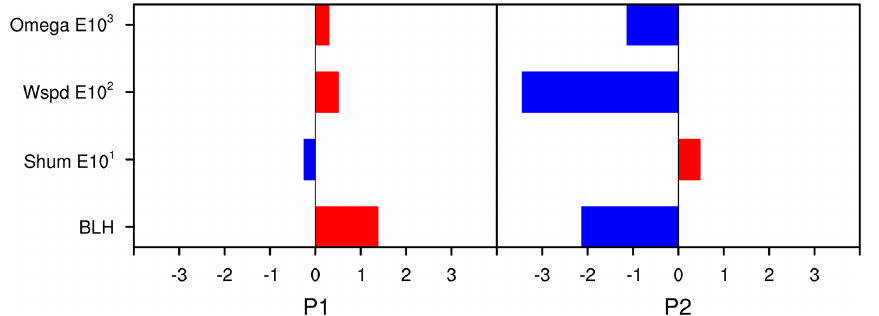
Figure 2. Area-averaged linear trends of the BLH (unit: myr − 1 ), specific humidity (unit: %10yr − 1 ), surface wind speed (unit: ms − 1 10 2 yr − 1 ) and omega (unit: pascalss − 1 10 3 yr − 1 ) over NC in early winter for the 1991–2010 (P1) and 2010–2018 (P2) periods. All datasets were 5-year running averages before calculating the